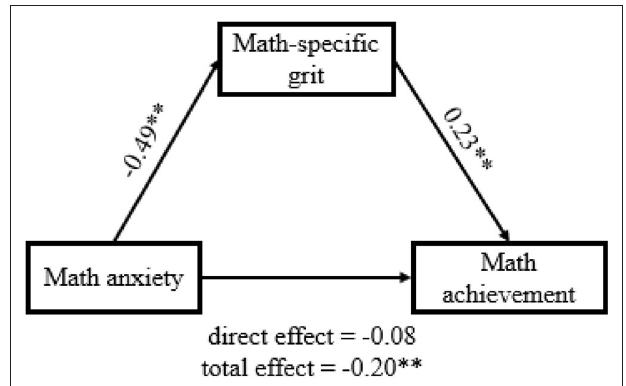
FIGURE 1 | Mediation model of math anxiety as a predictor of math achievement mediated by math-specific grit. Standardized regression coefficients are displayed for all paths. ** p <